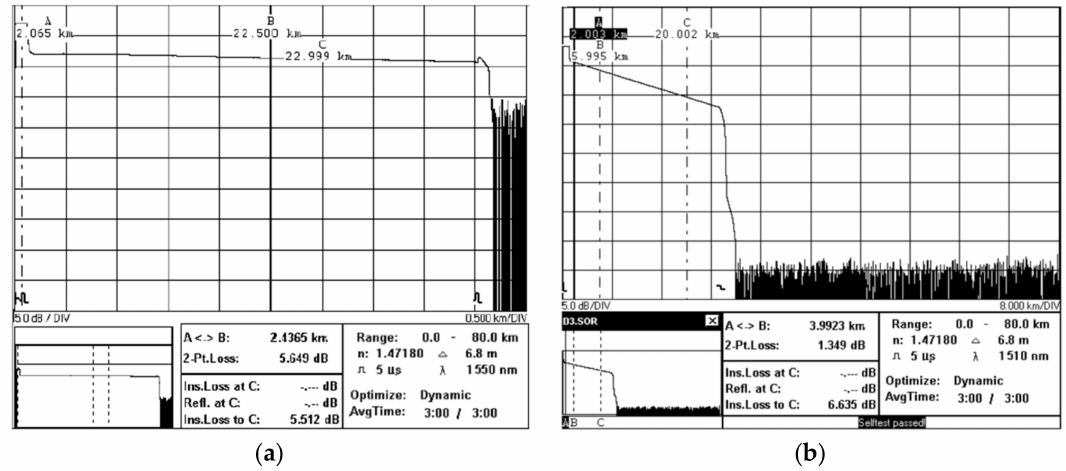
Figure 8. Preliminary OTDR test traces; ( a ) OTDR alone, ( b ) OTDR with the front-end